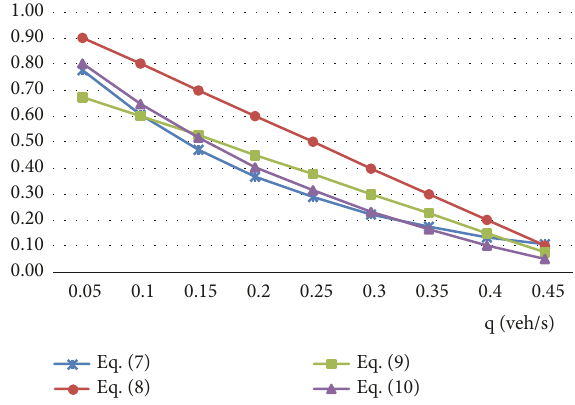
Figure 1: The ratio of free flow using different equation ( 𝑡 𝑚 = 2𝑠, 𝑏 = 2.5,𝑘 = 2.2 ). 𝑑 Table 3: Critical gap and following gap estimated in HCM 2010